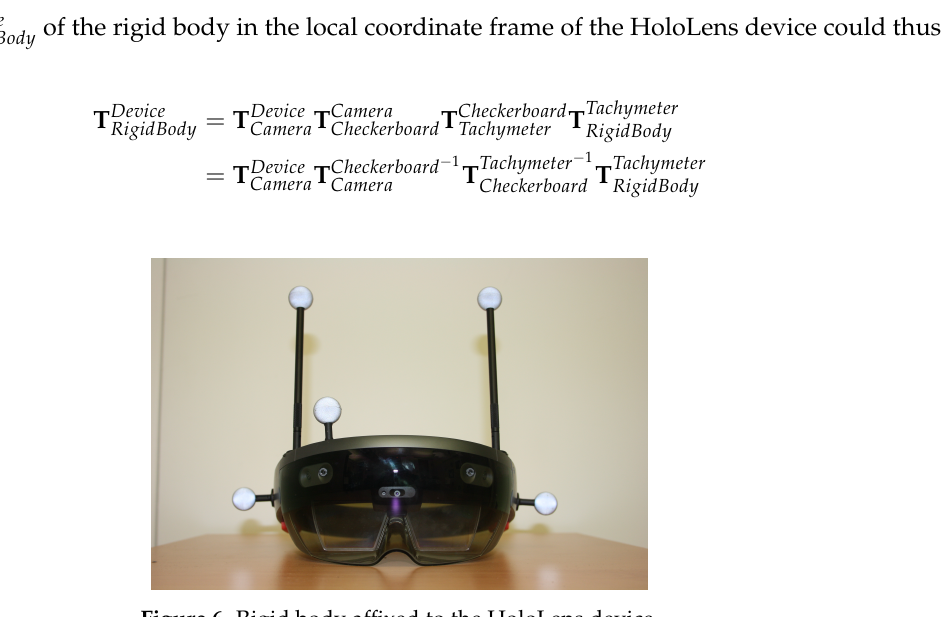
Figure 6. Rigid body affixed to the HoloLens